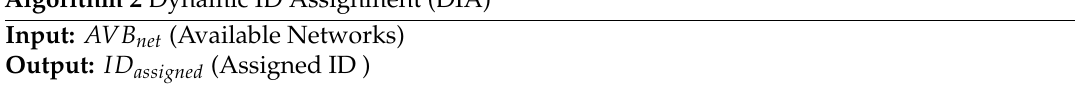
Algorithm 2 Dynamic ID Assignment